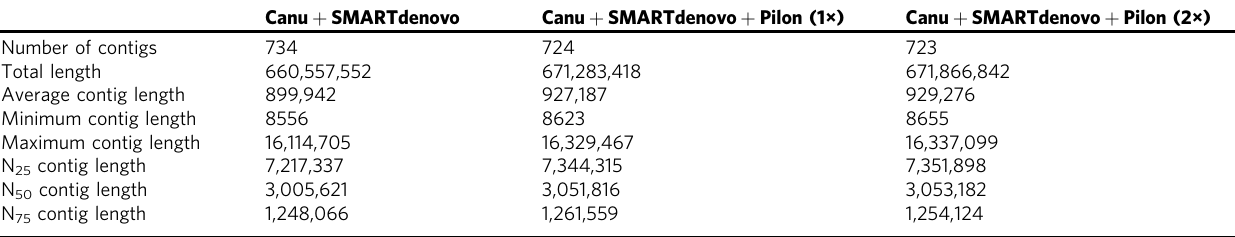
Table 1 Summary of ONT assembly metrics